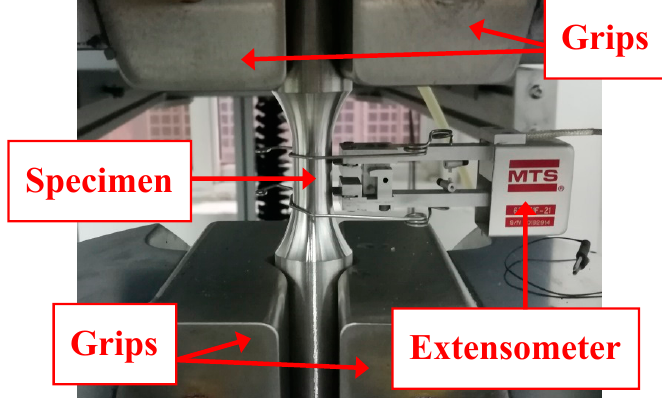
Figure 4. Arrangement of the